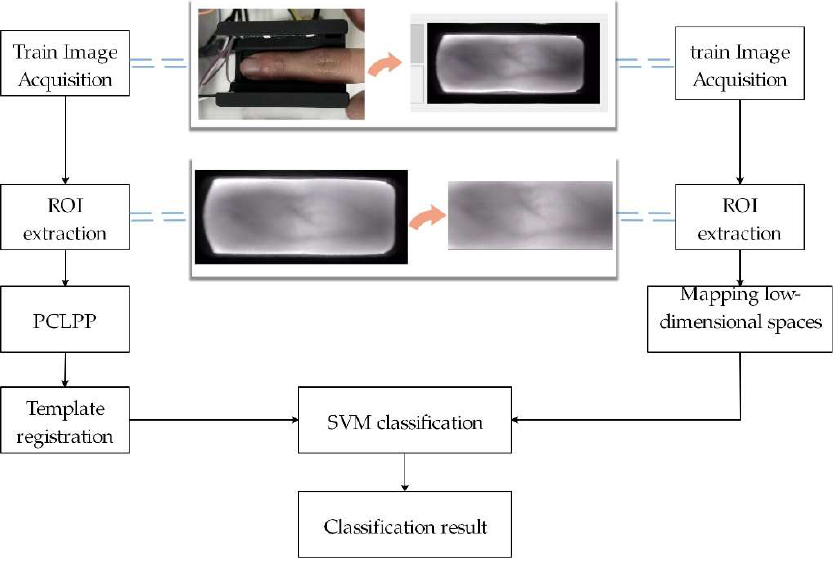
Figure 1. Finger Vein Recognition Framework.